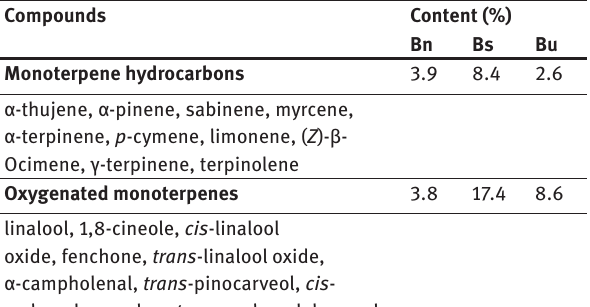
Table 6: Chemical composition of the essential oils of B. nigra